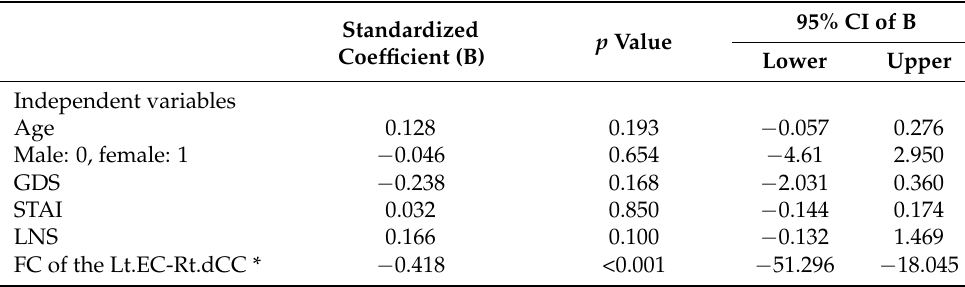
Table 3. Linear regression between UPSIT and